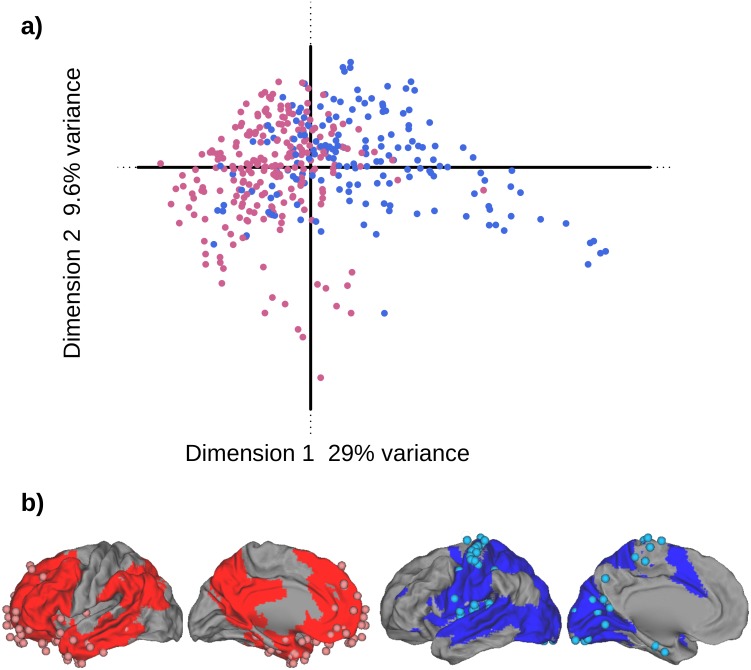
Differential distribution of gene expression: CA analysis.
a) Dimensions 1 and 2 as extracted by a CA performed on the 394 regions and the 938 genes. The dots represent the factor scores for the regions; each dot is colored in red or blue depending on the represented region localization within (respectively) PTF or VSA. The eigenvalue of Dimension 1 (λ1 = 4.59–03) represents 29% of the total variance, The eigenvalue of Dimension 2 (λ2 = 1.51–03) represents 9% of the total variance. b) The localization of the cortical regions on the brain with PTF and VSA rings colored in, respectively, dark red and dark blue. Light red dots represent regions with significant negative factor scores (BT<–2.00) whereas light blue dots represent regions with significant positive factor scores (BT>2.00).